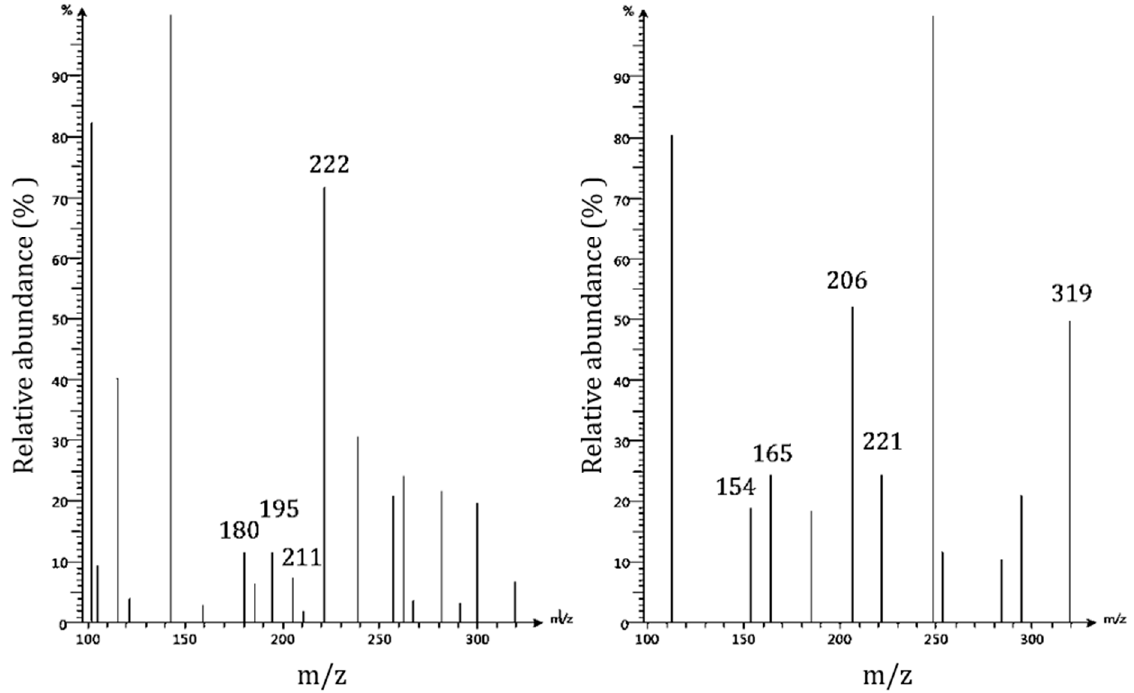
Figure 4. Bioactive characterization of acid hydrolyzed ethanolic extracts of Nacono cultivar by FIA-ESI-MS. Mass spectrums by flow injection-electrospray ionization-mass spectrometry (FI-ESI-MS) of acid hydrolyzed (1% HCl v / v in methanol) ethanolic extracts of Nacono cultivar with ion mode switching every second. Protonated ions (Left): Coniferyl alcohol (179 u), phenolic 8-end G( β -O-4 ′ )G dilignol ( m / z 195), Sinapyl alcohol S-lignol (210 u), and aliphatic 4-end of G( β -5 ′ )G dilignol (221 u). Deprotonated ions (Right): Vanillyl alcohol (154 u), guaiacylpropane (166 u), phenolic 8-end of G( β - β′ )G dilignol (m/z 206), aliphatic 4-end of G( β -5 ′ )G dilignol, and guaiacylglycerol- β -guaiacylether (320 u). Table 3. Identified bioactive components characterized by FIA-ESI-MS of acidified methanol (1% HCl) soluble compo- nents of pecan shell Nacono ethanol extracts.